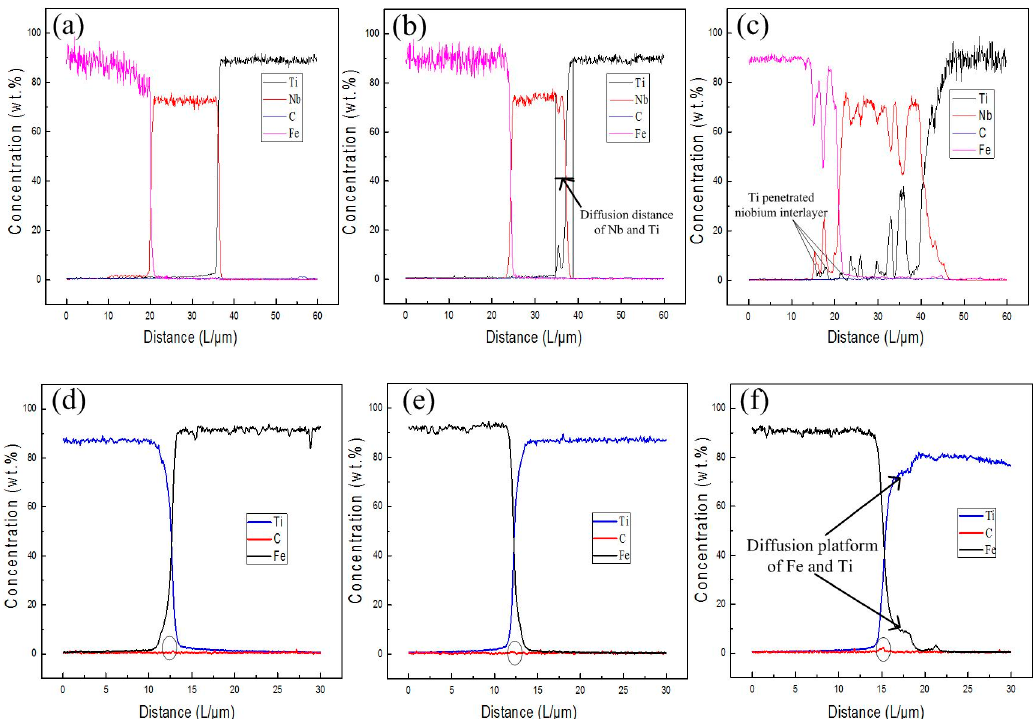
Figure 4. The WDS line scanning results traversing the clad interface at various heating temperatures: ( a ) 800 °C; ( b ) 900 °C and ( c ) 1000 °C for Ti/Nb/steel clad plate; ( d ) 800 °C; ( e ) 900 °C and ( f ) 1000 °C for Ti/steel clad plate.